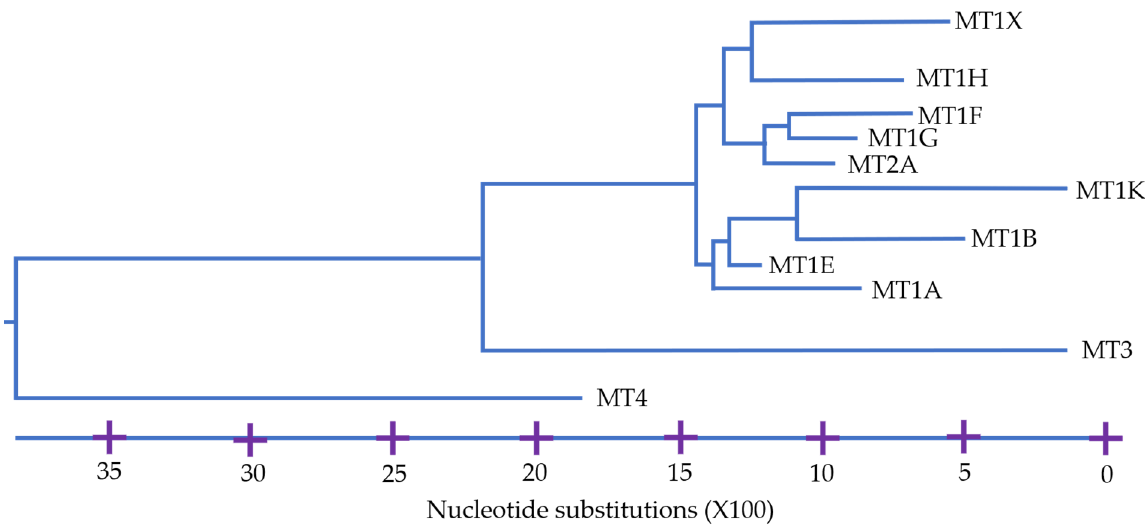
Figure 2. Phylogenetic tree of of protein sequences of MT proteins found in humans. (Adapted from [45] p. 304).